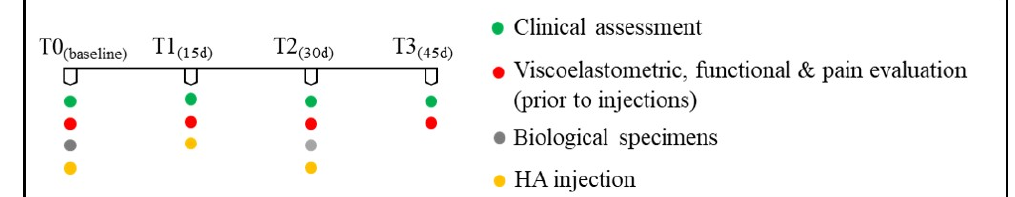
Figure 1. Experimental design.